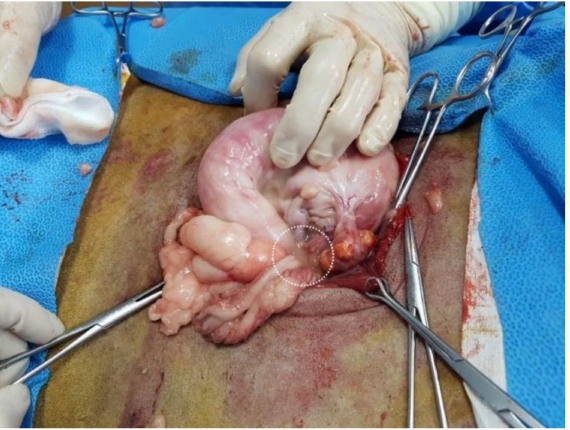
Figure 3. Intraoperative appearance of the uterus of a lion ( Panthera leo ) with pyometra. There is pus leakage (white dotted circle) around the